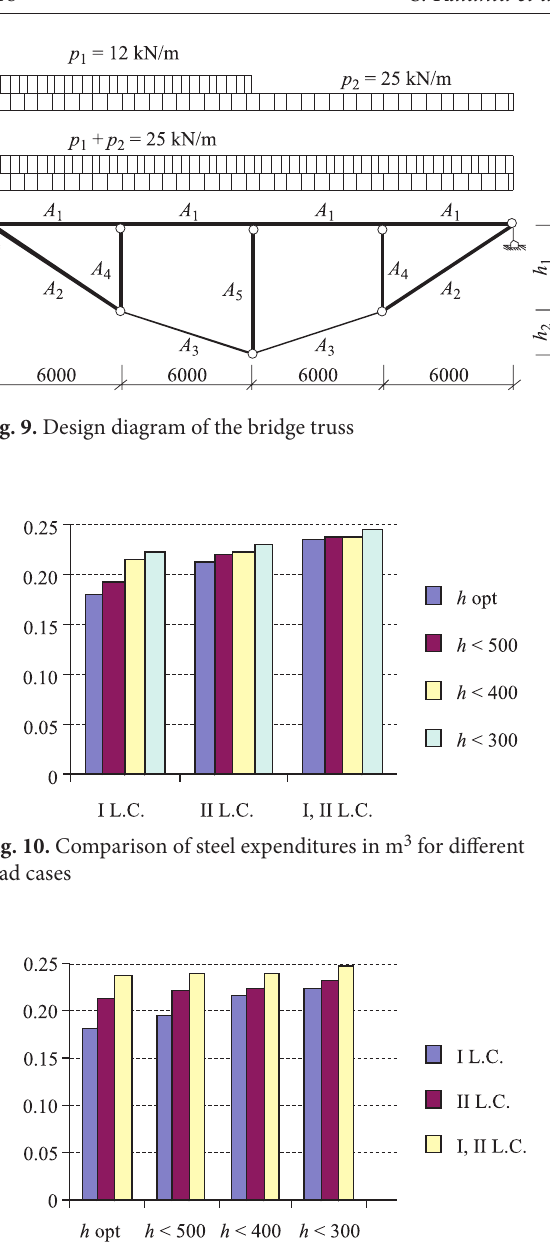
Fig. 13. Steel expenditures in m 3 for chords and webs with reference to the first load case